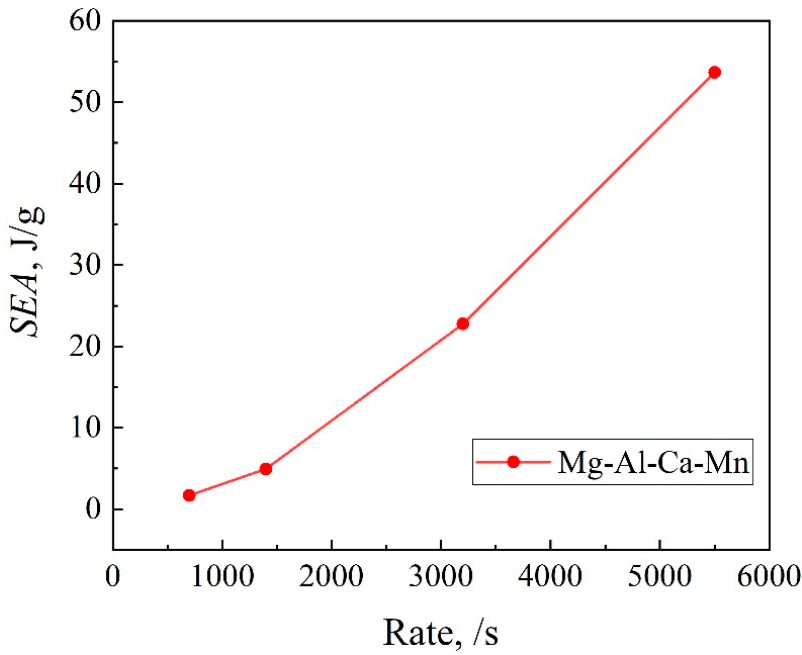
Figure 9. SEA of Mg-Al-Ca-Mn alloy under high strain rate compression in the ED direction.